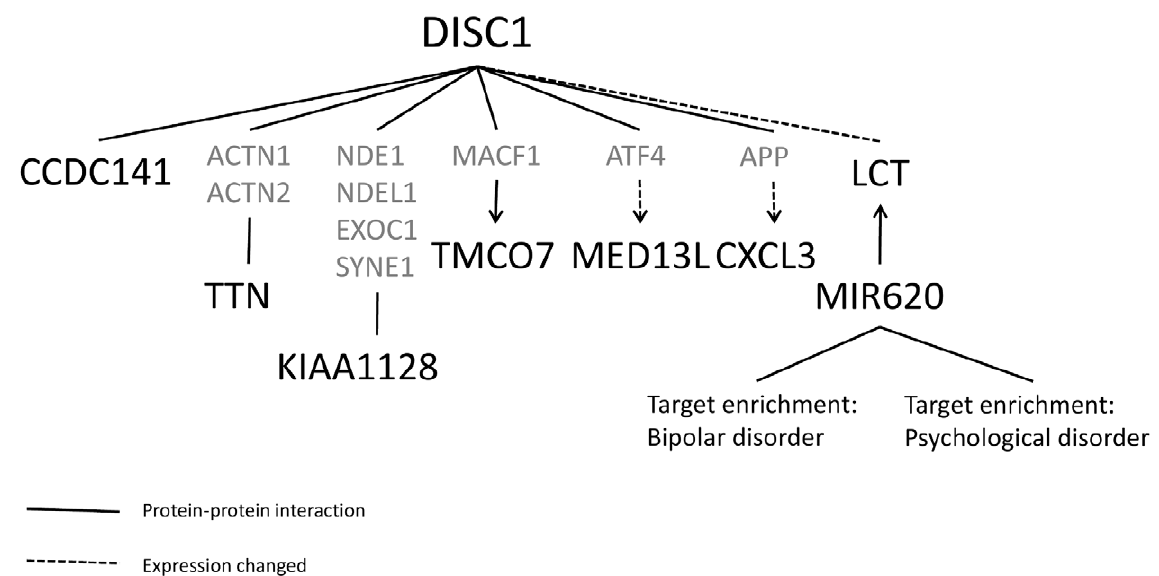
Figure 1. Illustration of how the identified molecules are relevant within the DISC1 pathway.